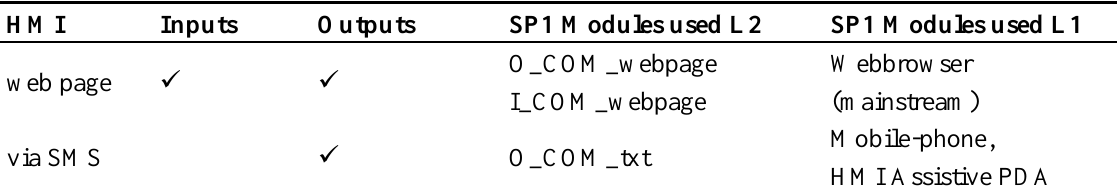
Table 4. Human Machine Interface Service description decomposing in framework